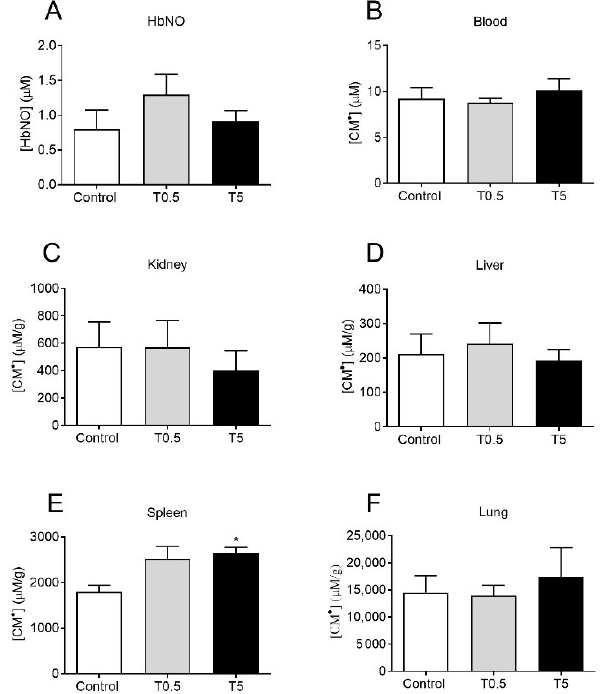
Figure 5. Quantification of ( A ) HbNO and ( B – F ) CM • in the blood, kidneys, liver, spleen, and lungs. The bars represent the concentration of HbNO and CM • in µ M (blood) or µ M/g for the different organs harvested 10 months after the administration of saline or DMSA-MNP (0.5 and 5 mg Fe/kg). The values represent the mean ± SEM. * p < 0.05, compared to the control group; one-way ANOVA, followed by Tukey’s multiple comparison test.